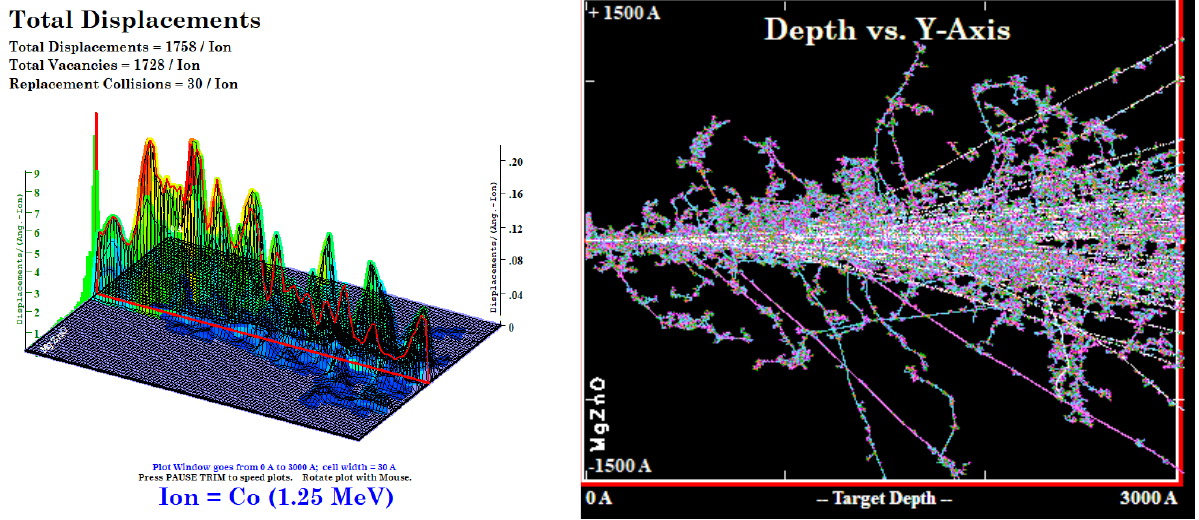
Figure 8. 3D plot of the total displacements and energy dispersion within the MgZnO cell with the 1.25 MeV radiation .